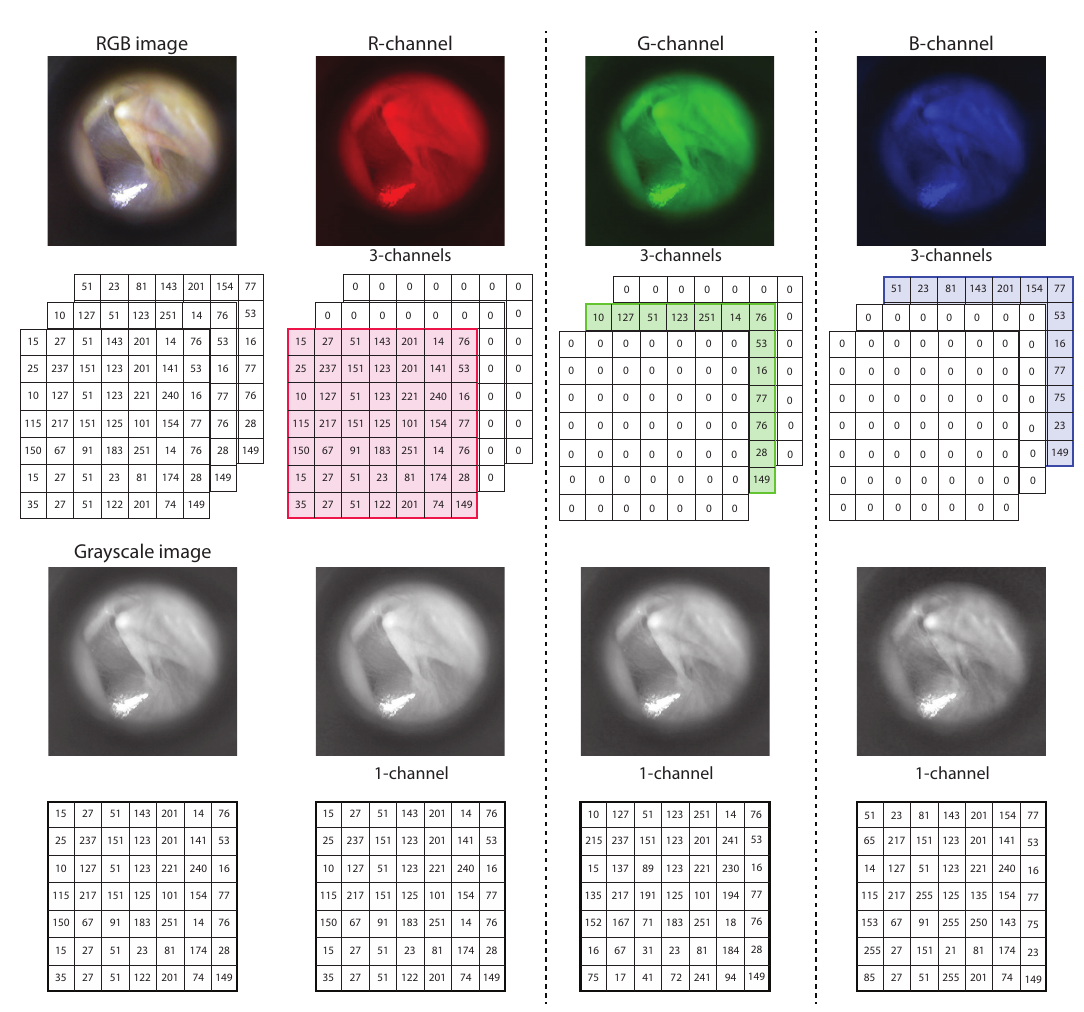
Figure 2. Matrix representation of a digital image: (upper row, from left to right) image in the RGB color space, 3-channel image with the non-zero red channel, 3-channel image with the non-zero green channel, 3-channel image with the non-zero blue channel; (lower row, from left to right) weighted linear combination grayscale image, red channel grayscale image, green channel grayscale image, blue channel grayscale